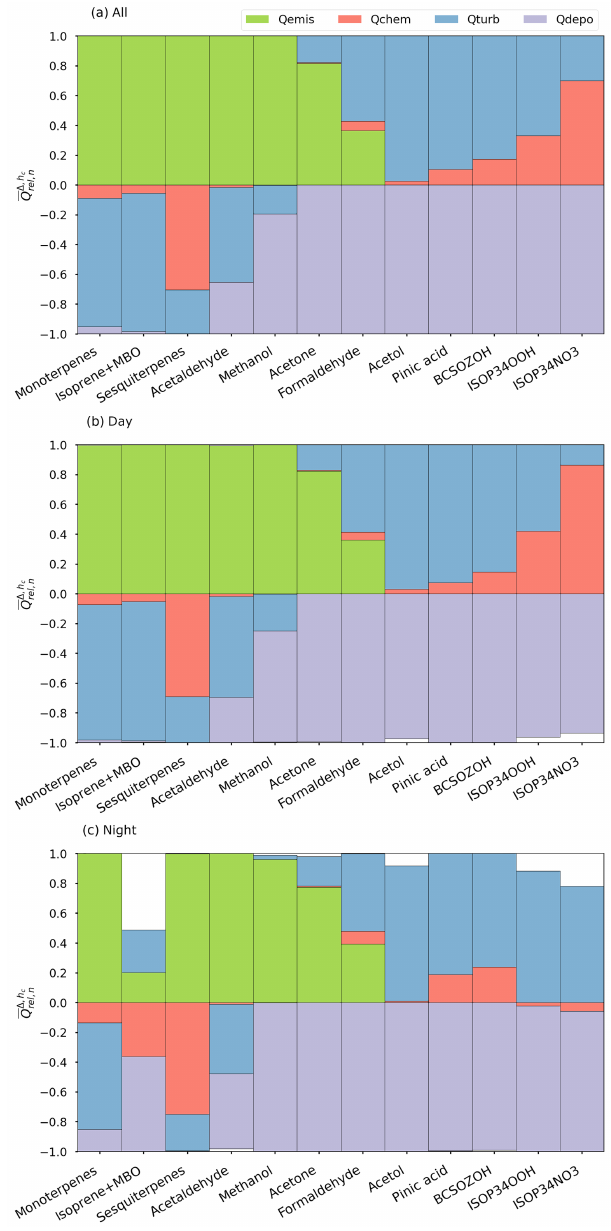
Figure 5. Monthly-averaged relative contributions of in-canopy (cid:49),h c sources and sinks ( Q rel ,n ), including gas emissions (emis, green), net chemical production and loss (chem, red), turbulent transport (turb, blue), and gas dry deposition (depo, purple) for selected BVOCs during (a) the whole month, (b) daytime, and (c) nighttime.